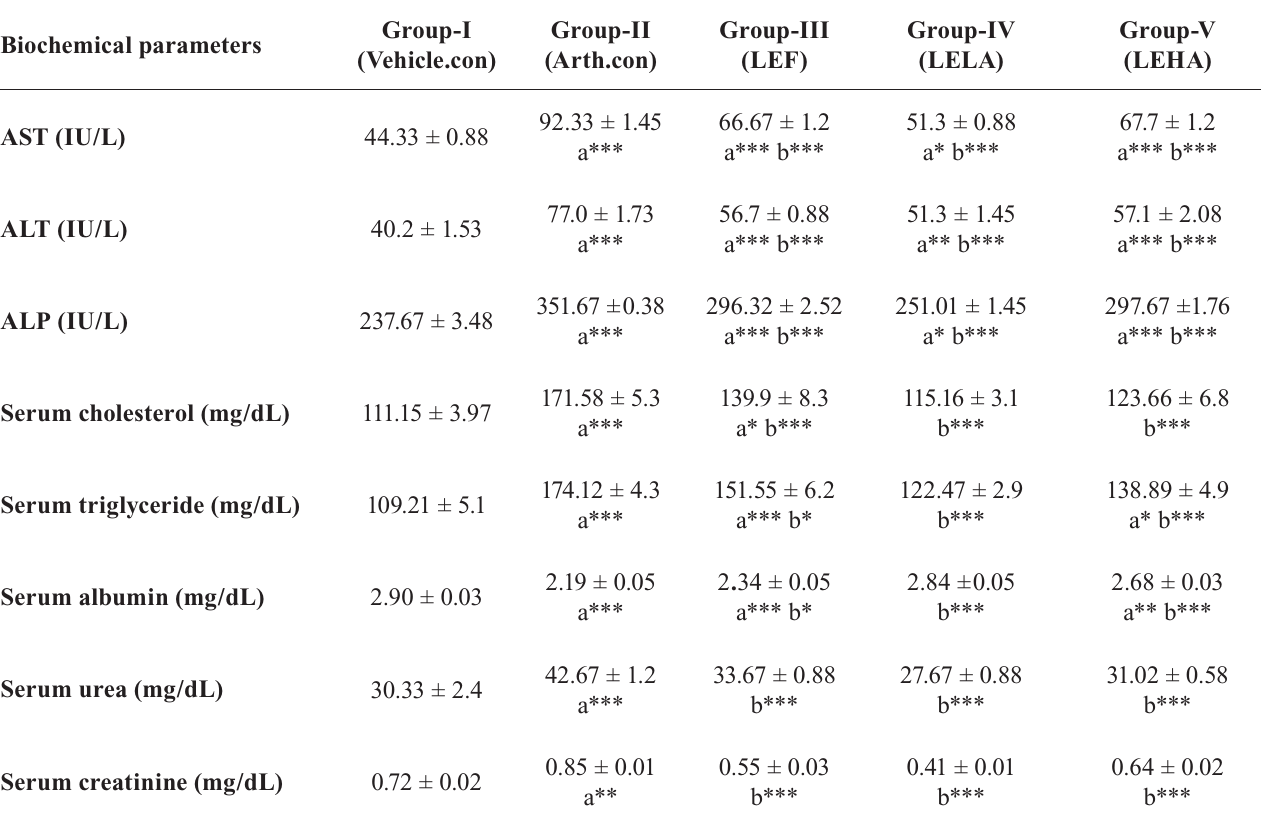
TABLE XII- Effect of leflunomide and amitriptyline on Biochemical parameters in FCA induced Arthritic rats